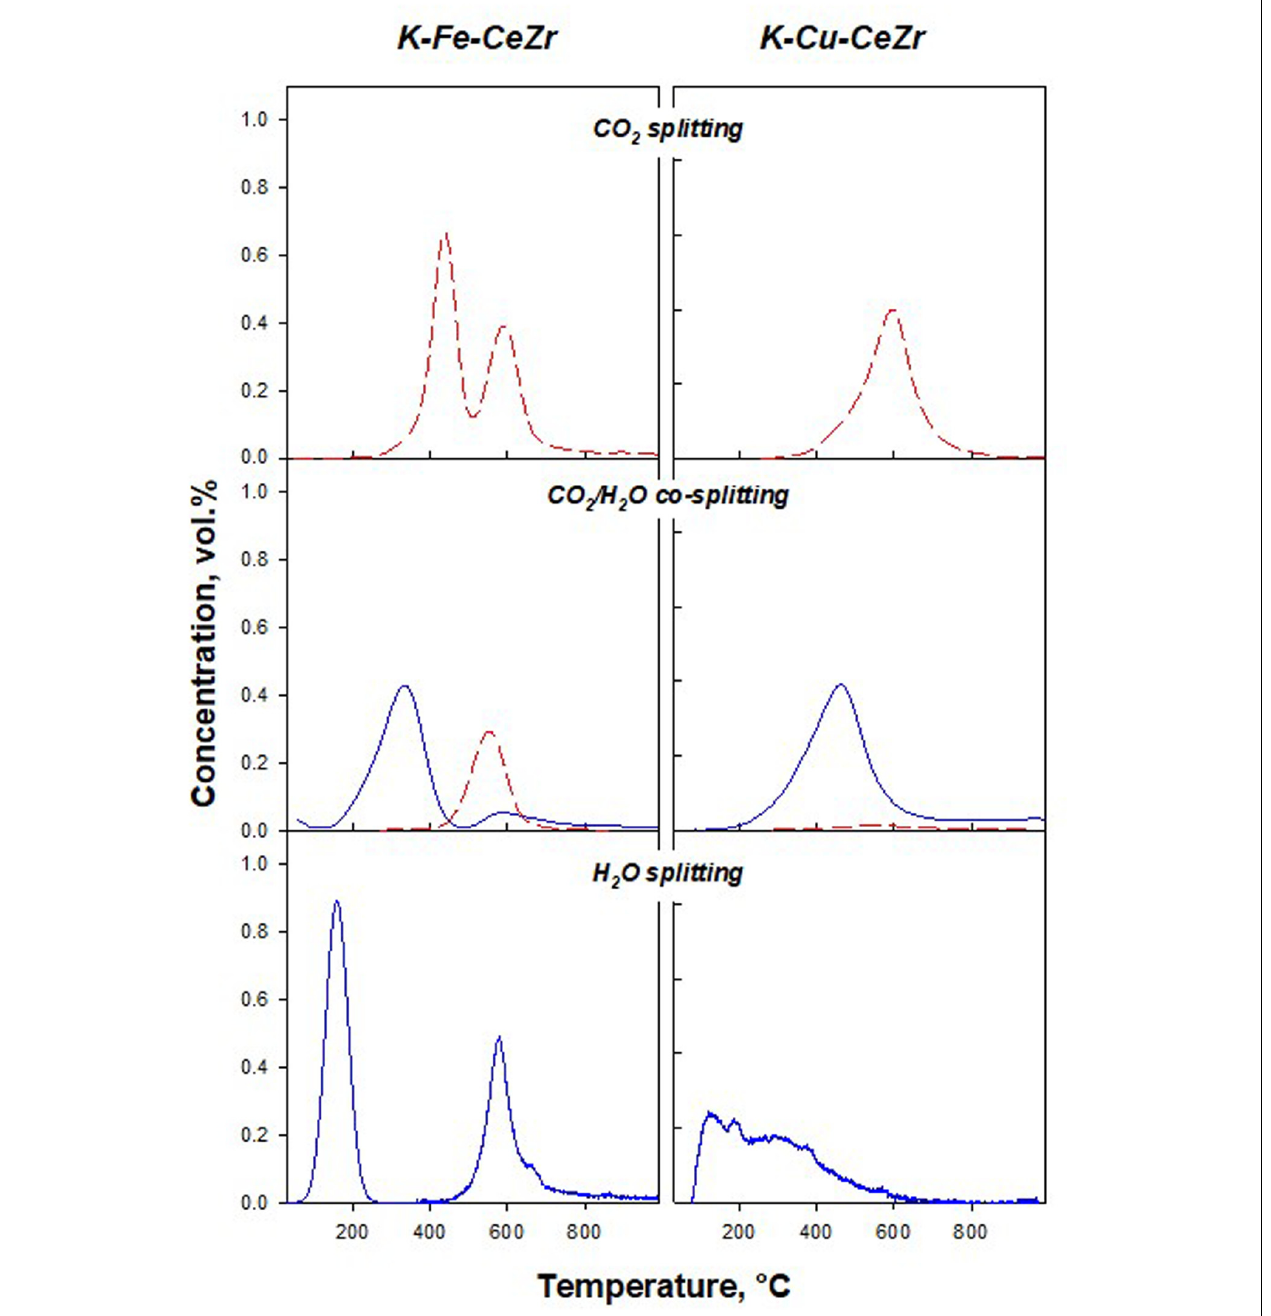
FIGURE 1 | H 2 (blue solid lines) and CO (red dashed lines) concentration profiles during splitting tests under different oxidizing streams on K-Fe-CeZr (left) and K-Cu-CeZr (right)